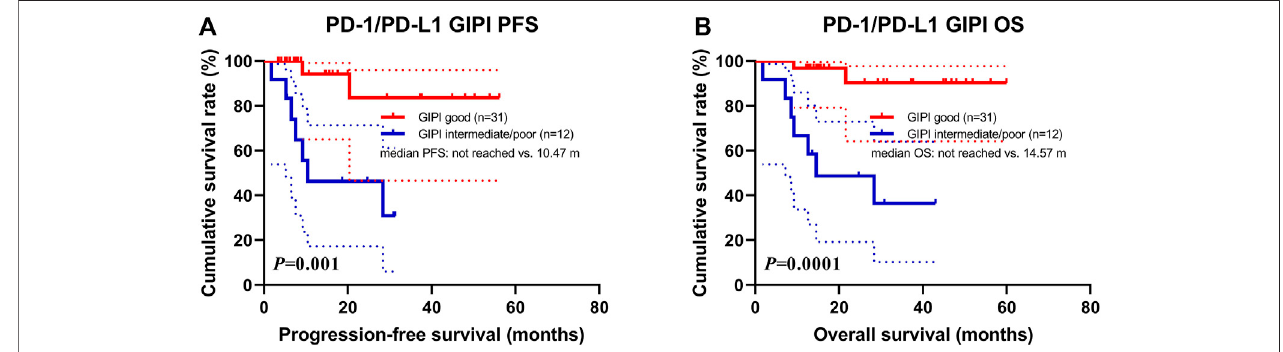
FIGURE 3 | Survival according to PD-1/PD-L1 positive expression groups for (A) progression-free survival (PFS) and (B) overall survival